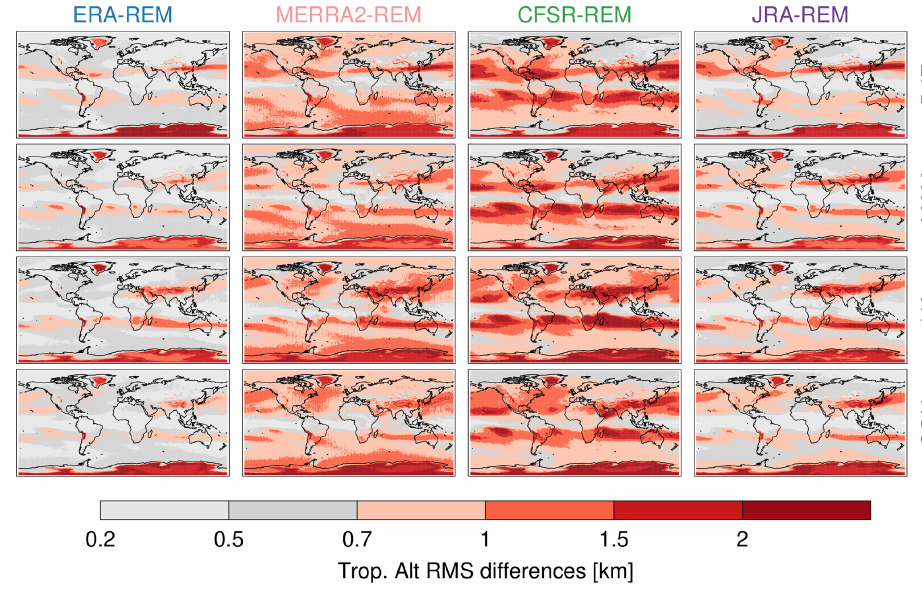
Figure A4. Seasonal root-mean-square (RMS) daily (1980–2014) 2PVU dynamical tropopause altitude differences.